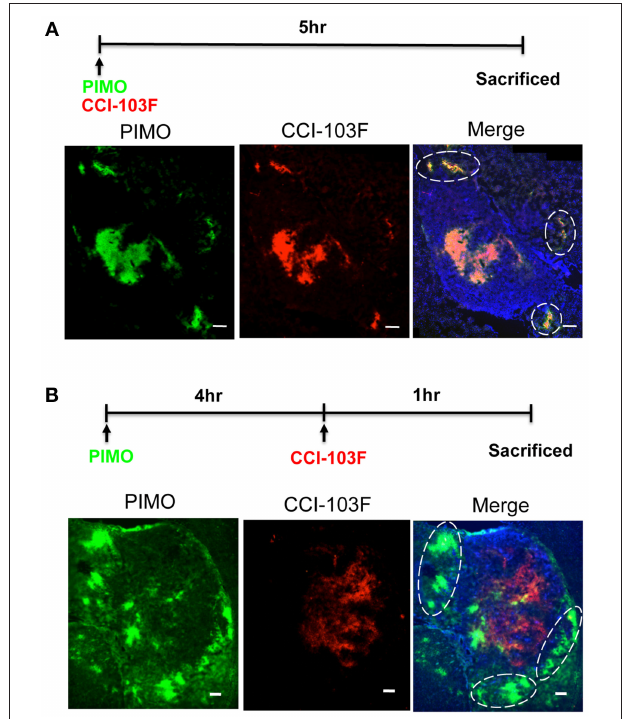
FIGURE 4 | Dynamic shift of hypoxia pattern in ALTS1C1 tumors. The procedure of dual hypoxia tracer was described clearly in the materials and methods section. Dual hypoxia markers, PIMO (green) and CCI-103F (red), were injected simultaneously (A) or 5 and 1h, respectively, before sacrifice (B) into mice. The peripheral hypoxia was circled with dotted line. Nucleus was stained by DAPI (blue). Scale bar = 200 µ m.